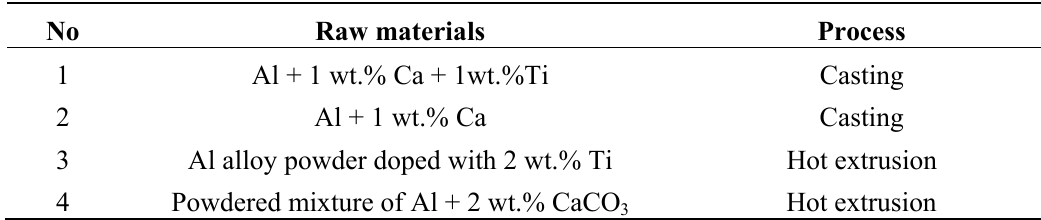
Table 6. Characteristics of solid